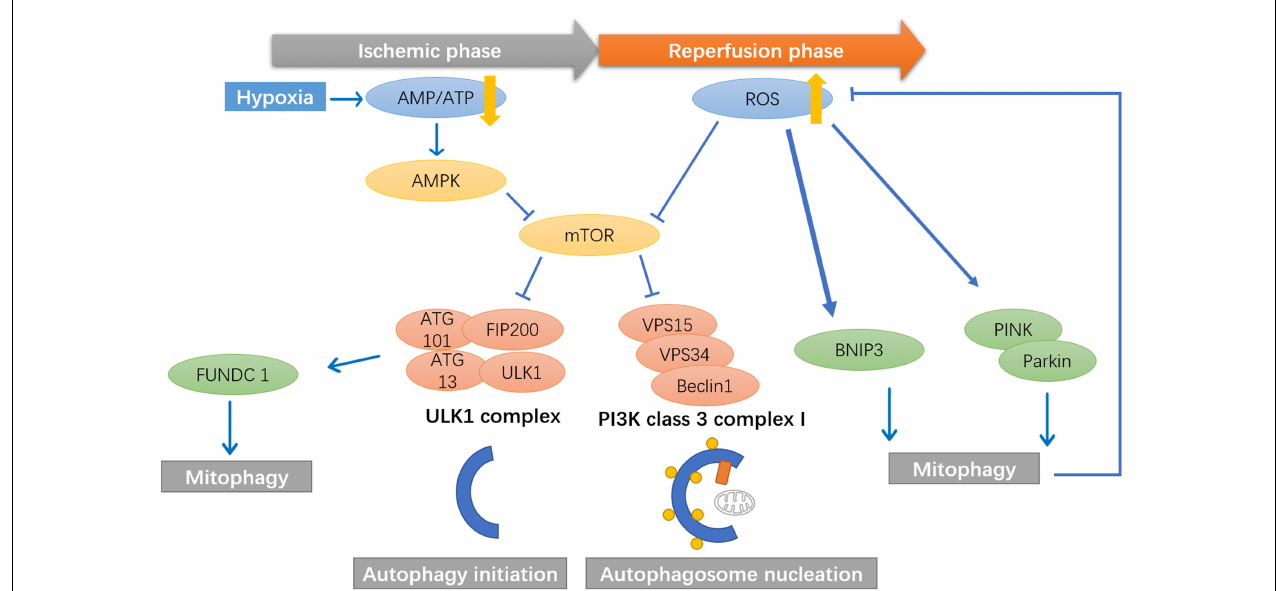
FIGURE 3 | Mitophagy pathways are activated during ischemic/reperfusion through multiple signals. During the ischemic phase, ATP production rapidly decrease, which activates AMPK pathways to initiate autophagy. AMPK activates the phosphorylation of ULK1, which will then activate the class III PI3K complex (beclin 1, VPS34, and VPS15) that initiate the nucleation of phagophore. ULK1 has also been found to activate the FUNDC1 receptor, which may collaterally activate mitophagy. During the reperfusion phase, the mTOR pathways is inhibited by ROS signals, thereby promote the initiation and nucleation of the autophagosome. ROS has been found to activate BNIP3 and PINK1/Parkin mediated mitophagy in cerebral ischemia and reperfusion.